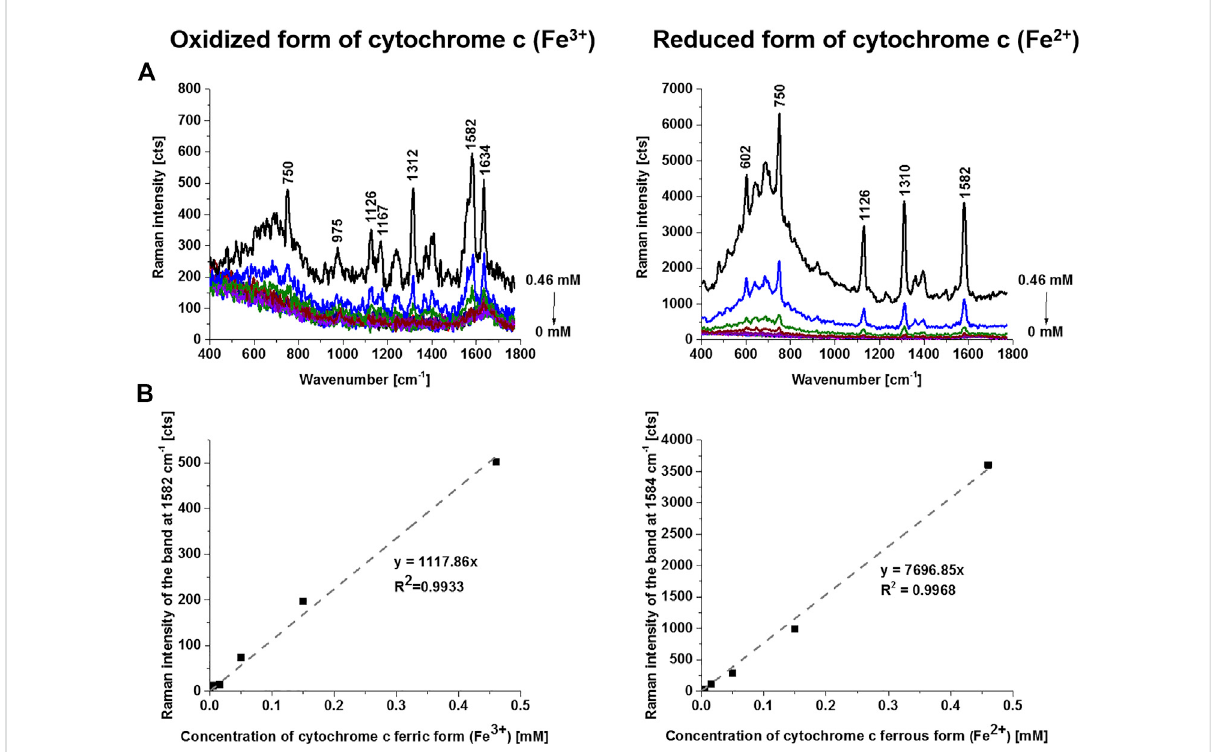
FIGURE 3 Raman spectra of oxidized (ferric form, Fe 3+ ) and reduced (ferrous form, Fe 2+ ) forms of cytochrome c as a function of concentration (PBS solutions (0 – 0.46 mM) (A) , Raman band intensity at 1582 cm − 1 as a function of cytochrome c concentration (B) . Experimental conditions: excitation 532 nm, laser power 10 mW, integration time 0.5 s, 10 accumulations, 1 mm light path quartz cuvette. Reduction agent NaBH 4 in tenfold